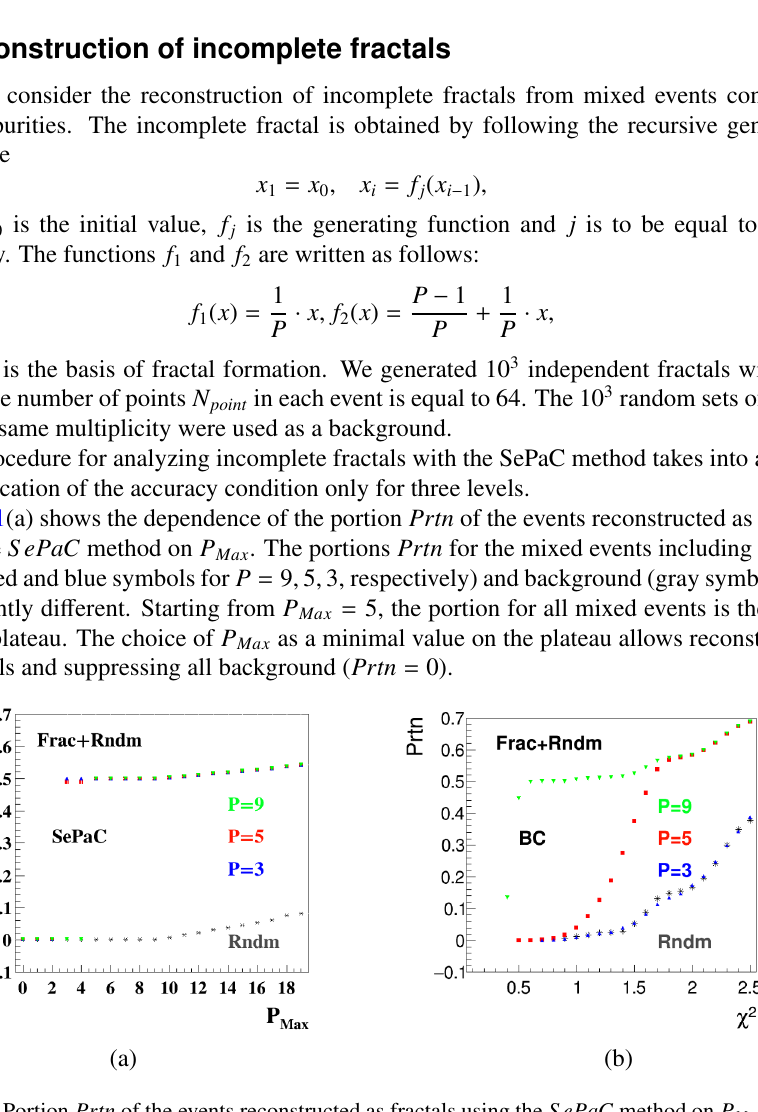
Figure 1. Portion Prtn of the events reconstructed as fractals using the SePaC method on P Max (a) and the BC method on χ 2 lim